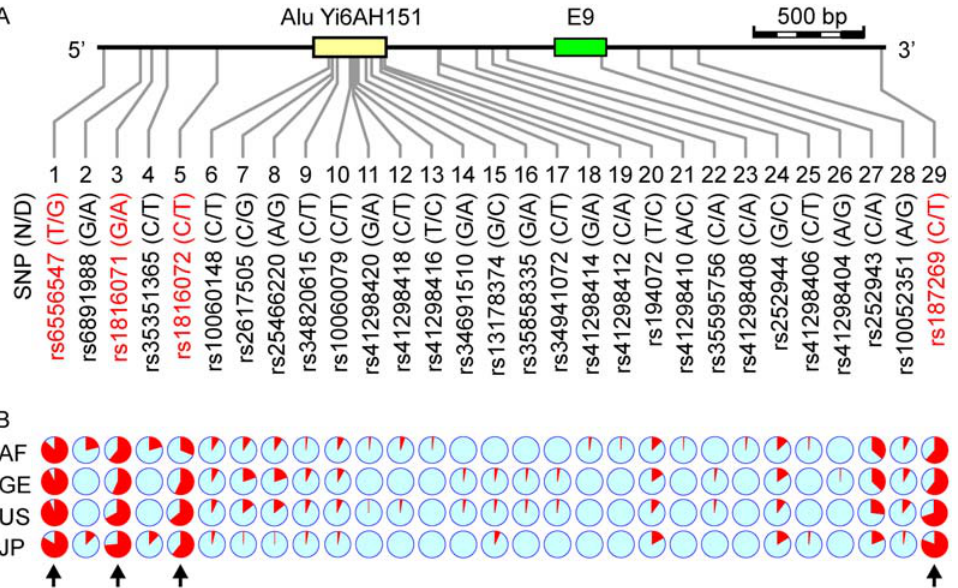
Figure 1. SNP positions and allele frequencies. (A) Positions of all twenty-nine SNPs in a 3551-bp region of schizophrenia-associated GABRB2 from base 160,689,203 to base 160,692,753 of chromosome 5 contig NT_023133.12 are shown to scale. Solid horizontal lines represent introns flanking Exon 9 (green box) and the human specific Alu insert Yi6AH151 (yellow box), which spans bases 160,691,468 and 160,691,782. The ID numbers of SNPs with prefixes ‘‘rs’’ or ‘‘ss’’ are labeled according to the Single Nucleotide Polymorphism database (dbSNP; www.ncbi.nih.gov/SNP). The two alleles for each SNP are shown in parentheses following the SNP ID number in the format of (ancestral base)/(derived base). (B) Population allele frequencies of each SNP are represented by pie-charts for the AF, GE, US and JP populations, where the cyanine wedge indicates the frequency of the ancestral allele (N), and the red wedge the frequency of the derived allele (D). The four SNPs with high derived allele frequencies (high-D SNPs) are indicated by arrows and red ID Number.